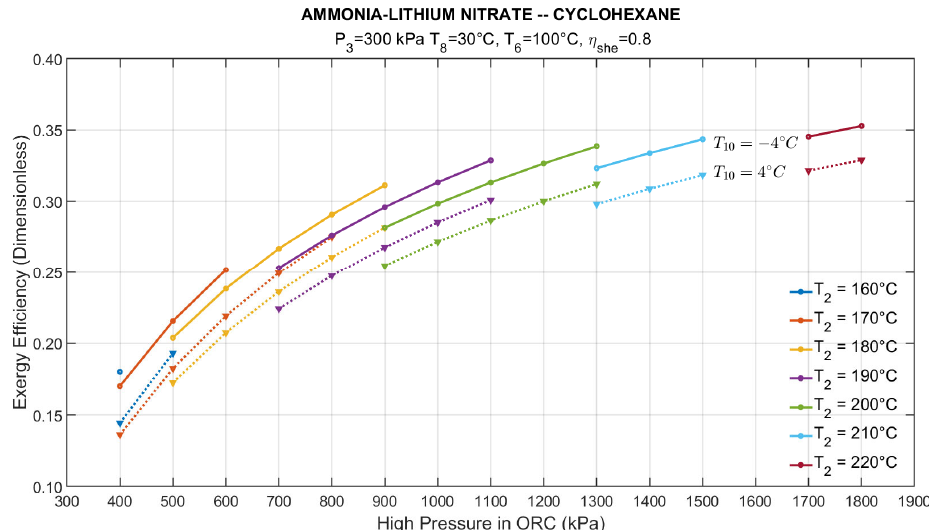
Figure 10. NH 3 -LiNO 3 –C 6 H 12 exergy efficiency as a function of heat supply temperature and higher pressure of the ORC.